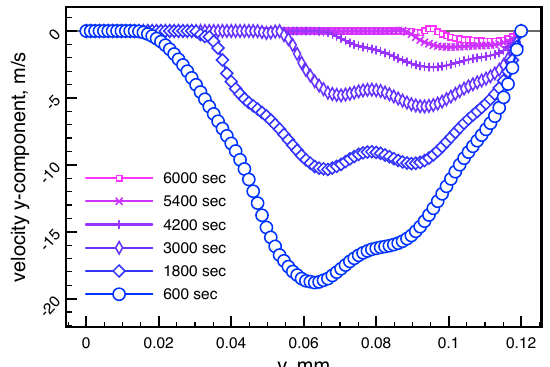
Figure 8. Melt velocity decreasing during solidification. The location of line is correspond to the near wall UDV transducer.